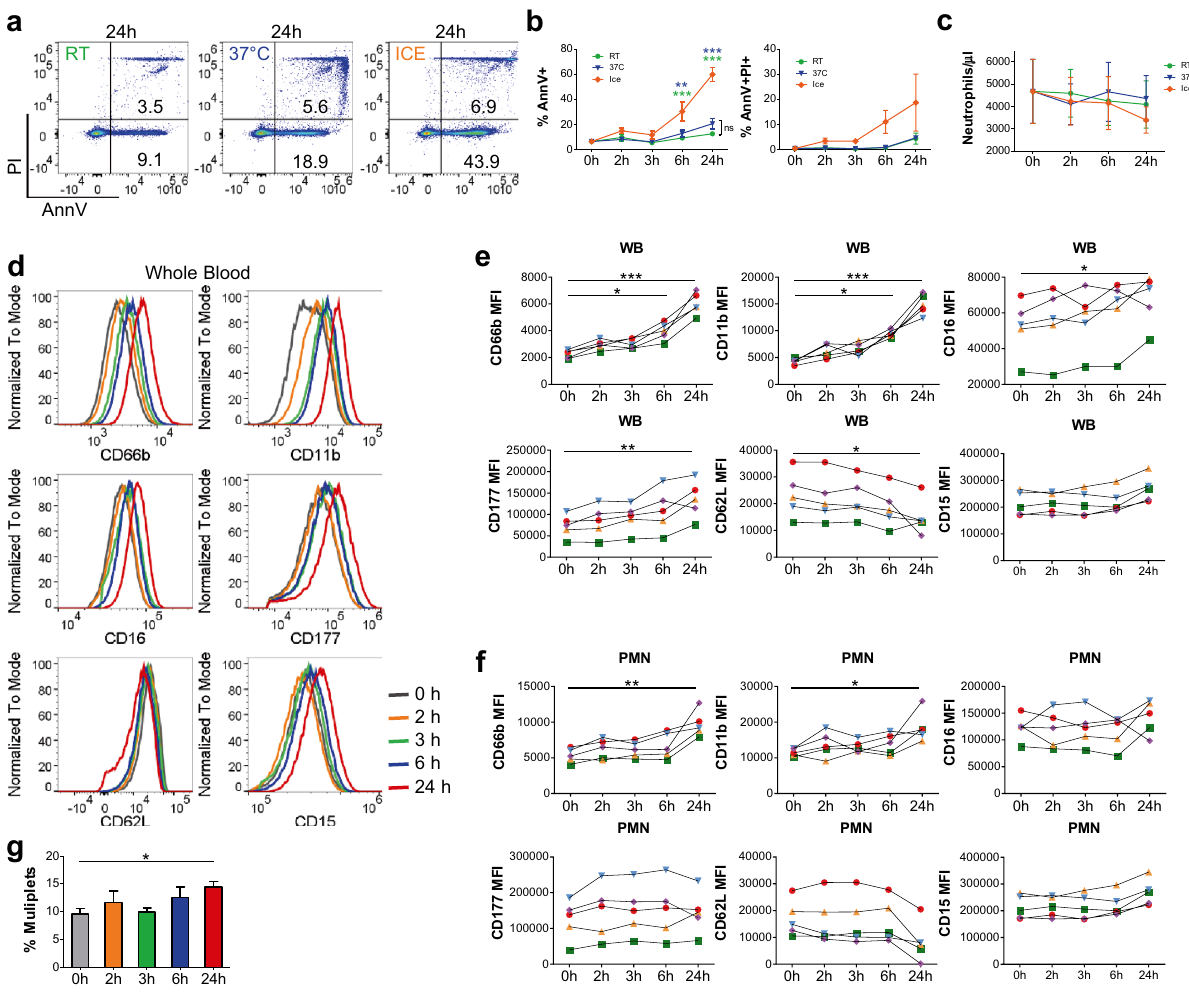
Figure 5. The impact of sample processing delays and temperature on neutrophil phenotype. ( a ) Representative plots of neutrophil apoptosis and viability following 24 h of WB incubation at the indicated temperatures. ( b ) Quantification of Annexin V + (apoptotic, left) and Annexin V + /PI + (late apoptotic/necrotic, right) neutrophils over time from WB incubated at the indicated temperatures. ( c ) Neutrophil recovery per microliter of WB over time following incubation at the indicated temperatures. ( b , c ) Results were compared using a two-way ANOVA, with Bonferroni post-tests * p < 0.05, ** p < 0.01, *** p < 0.001, n = 3 per condition. ( d ) Representative histogram overlays of neutrophil surface protein levels assessed following RT incubation for the indicated amount of time following blood draw. ( e , g ) Surface levels of indicated proteins over time on neutrophils from ( e ) WB or ( f ) the PMN layer of a single Ficoll gradient. Each color represents measurements from the same sample over time, n = 5. ( g ) Comparison of the percentage of neutrophils forming multiplets in WB at the indicated time following sample collection, n = 6. ( e – g ) Results were compared using a Friedman test with Dunn’s multiple comparison post-hoc test * p < 0.05, ** p < 0.01. All samples were collected in ACD tubes, incubated at RT, and stained at 4 °C unless otherwise